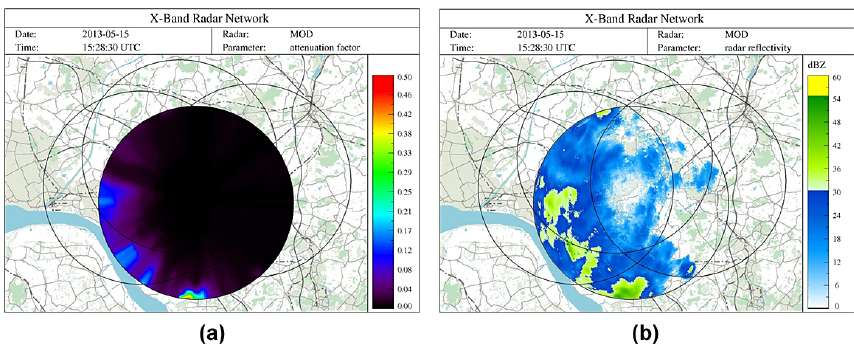
Figure 9. Attenuation correction for radar MOD for 15 May 2013, 15:28:30UTC: (a) attenuation factor field and (b) corrected dBZ field.